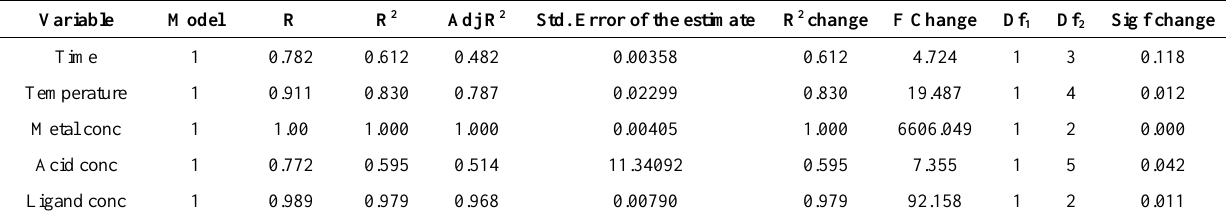
Table 1. Coefficient of correlation between the variables and amount Mn(II) H 2 SAL Complex extracted